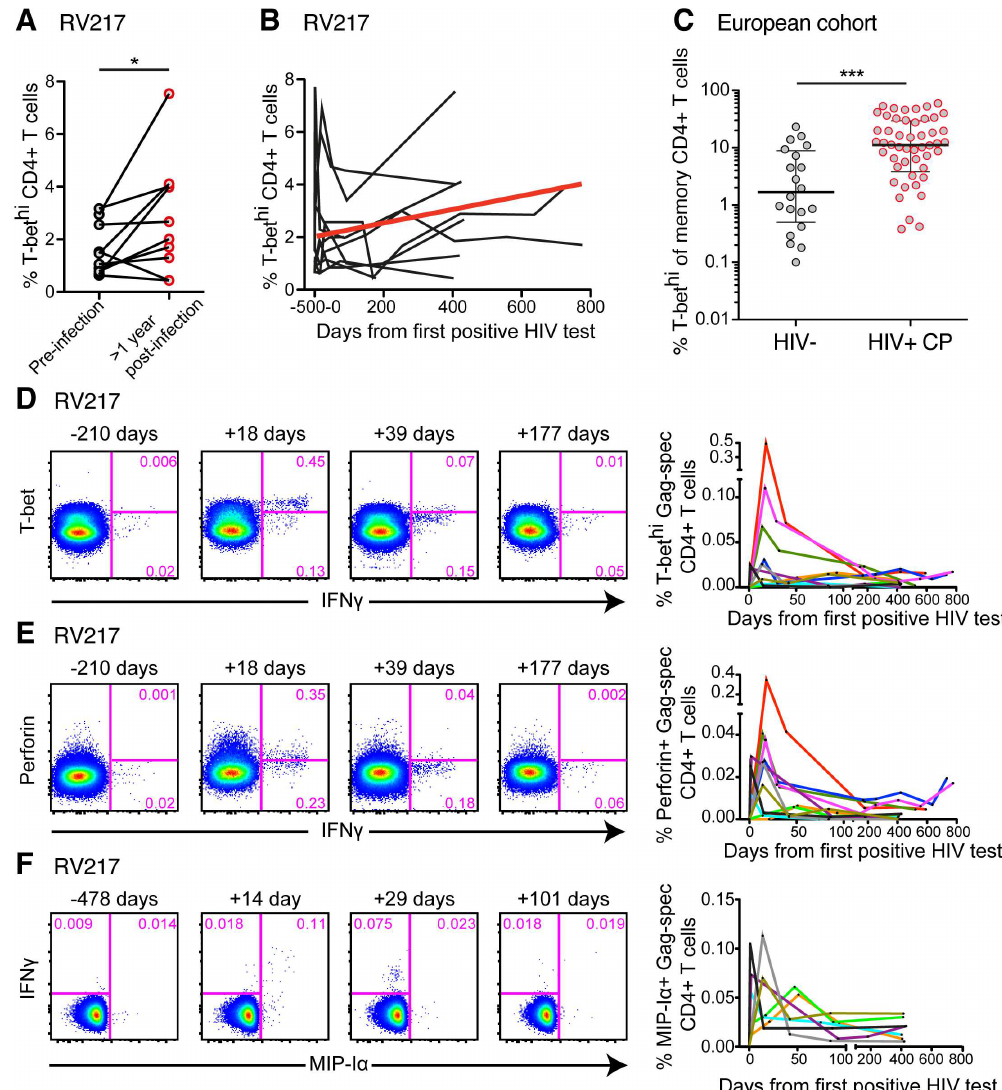
Fig 2. Temporal dynamics of T-bet hi expression and effector HIV-specific CD4+ T cell responses following HIV infection in blood. (A) Frequencies of T-bet hi CD4+ T cells before and first sample taken 1 year after HIV infection (n = 10). (B) Longitudinal changes of T-bet hi CD4+ T cells before and subsequently after HIV infection. Every individual is depicted with black connecting lines and red line indicate the estimated mean value (linear regression) over time (n = 10). (C) Frequency of T-bet hi expression on memory CD4+ T cells in HIV- and HIV+ chronic progressors (CP) (D) T-bet, (E) perforin and (F) MIP-1 α expression by IFN γ + Gag-specific CD4+ T cells before and subsequently following HIV infection (n = 10). The colored lines represent each subject and their frequencies of T-bet hi , perforin+ and MIP-1 α + Gag-specific CD4 + T cells over time. A Wilcoxon or Mann-Whitney test was performed to compare the difference between groups; (cid:3) P < 0.05. Longitudinal data-points are derived from the RV217 cohort and cross-sectional data from the European